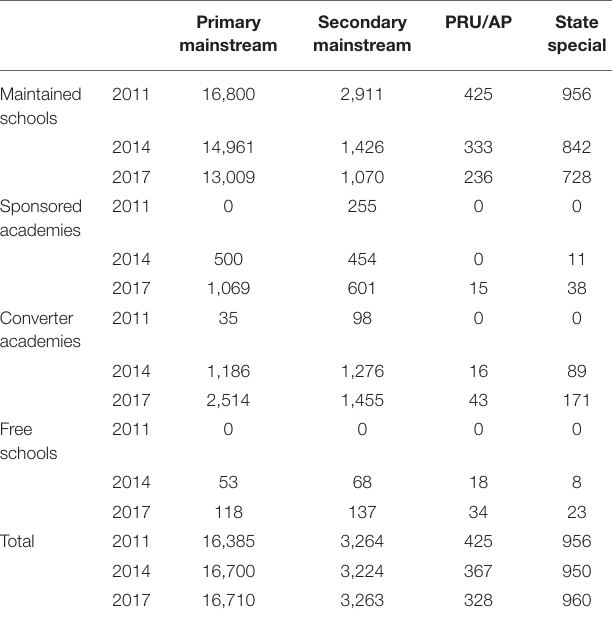
TABLE 2 | Sample structure by type of educational